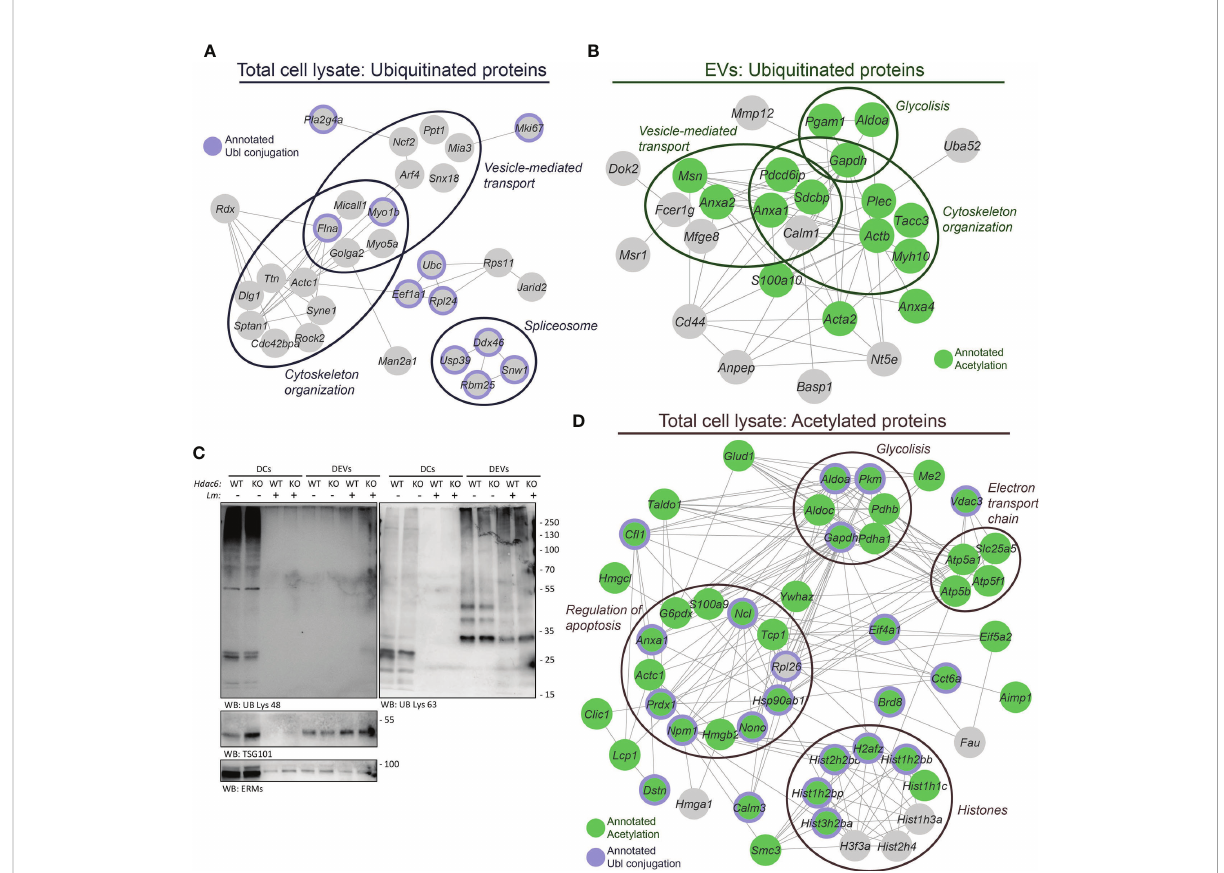
FIGURE 4 Post-translational modi fi cations play a role in infection and sorting to EVs. (A) The 41 ubiquitinated Lys sites identi fi ed in the DC lysates pertain to a set of proteins found signi fi cantly enriched in the following biological processes: cytoskeleton organization (GO:0007010), FDR= 0.00036; vesicle- mediated transport (GO:0016192), FDR= 0.0075; and spliceosome (mmu03040 KEGG pathway), FDR=0.0278. In addition, 11 of these proteins were annotated as Ubl conjugation (KW-0832, FDR= 0.0040) in the Uniprot database. (B) Analysis of the 49 ubiquitinated Lys sites identi fi ed in the EVs revealed a different pro fi le of ubiquitinated proteins as compared to the DC lysates. However, functional enrichment analysis showed an overrepresentation of proteins related to cytoskeleton organization (GO:0007010), FDR= 0.0119; regulation of vesicle-mediated transport (GO:0060627), FDR= 0.0037 and glycolytic process (GO:0006096), FDR= 0.0188. Fifteen of these ubiquitinated proteins were previously annotated under Acetylation (KW-0007, FDR= 5.8 · 10 -5 ) in the UniProt database. (C) Western blot analysis of protein ubiquitination. Protein extracts were prepared from EVs and Hdac6 +/+ (WT) or Hdac6 -/- (KO) DCs samples infected or not with Lm . Cells and EVs were blotted with an antibody against polyubiquitin chains linked through Lys48 ubiquitin (UB) residue (left panel) or Lys63 UB residue (right panel). TSG101 and ERMs were used as EV markers. Both panels correspond to same sample. (D) The 60 proteins harboring the 79 acetylated Lys sites identi fi ed in the DC lysates showed an overrepresentation of proteins implicated in chromatin organization (GO:0006325), FDR= 0.00032; regulation of apoptotic process (GO:0042981), FDR= 0.0205; glycolytic process (GO:0006096), FDR= 0.0014; and electron transport chain (WP295 WikiPathway), FDR= 0.0151. Out of these 60 acetylated proteins, 44 and 22 proteins were found annotated as Acetylation (KW-0007, FDR= 6.6 · 10 -25 ) and Ubl conjugation (KW-0832, FDR= 1.5 · 10 -6 ) in the UniProt database, respectively. The proteins annotated as Acetylation are indicated in green and proteins annotated as Ubl conjugation are denoted by a purple edge. Proteins are labeled according to gene